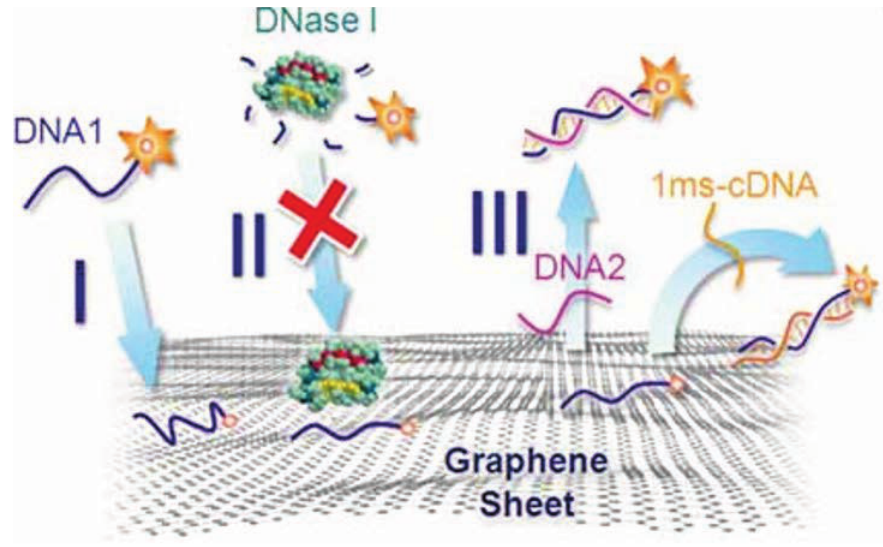
Figure 5. Schematic illustration of the constraint of DNA molecules on functionalized graphene and its effects. I) The single-stranded DNA can be effectively constrained on the surface of graphene via adsorption. II) DNAse I can digest free DNA but not graphene-bound DNA. III) The constrained DNA shows improved specificity response towards target sequences that can distinguish the complementary and single-mismatch targets. Reprinted with permission from [43 ]. Copyright 2010 WILEY-VCH [